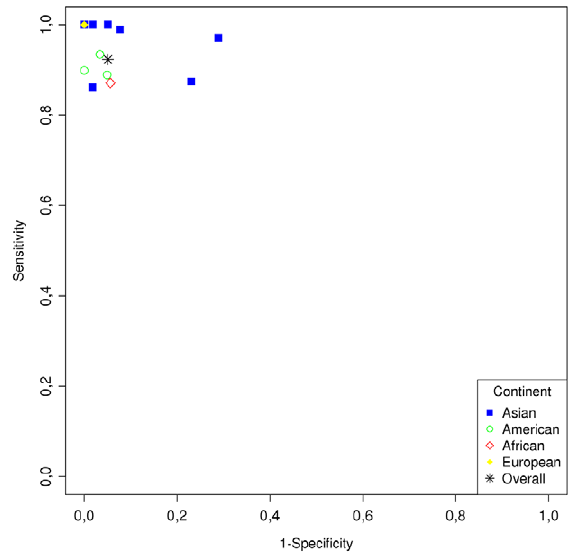
Figure 4. ROC plot showing the heterogeneity of strip test by